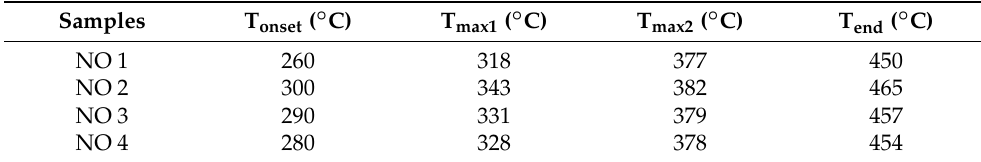
Table 10. Thermal degradation temperature of MREs with different ratios of NO:AO.